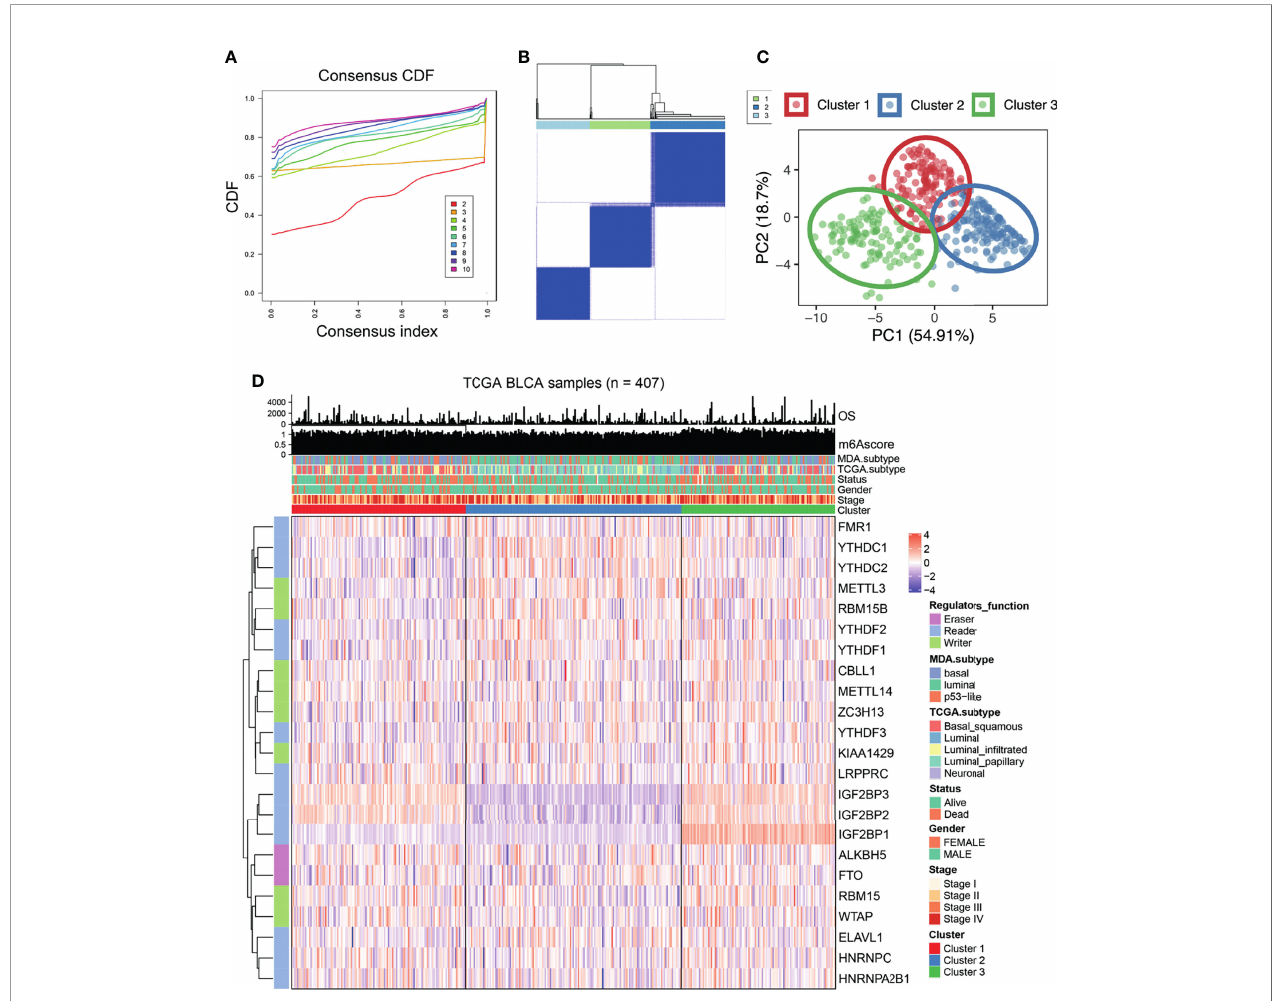
FIGURE 2 | The expression of 23 kinds of m 6 A regulatory factors identi fi ed three different methylation patterns. (A, B) According to the expression of 23 m 6 A regulatory factors, we classi fi ed 407 bladder cancer patients, and 3 was the optimal cluster number. (C) Principal component analysis showed that that all patients could be well classi fi ed into three subtypes. (D) Heatmap display showing the expression of 23 m 6 A regulatory factors among three different m 6 A modi fi cation patterns. The relationship between different m 6 A modi fi cation patterns and clinical features such as OS, m 6 Ascore, MDA typing, TCGA typing, status, gender, stage,